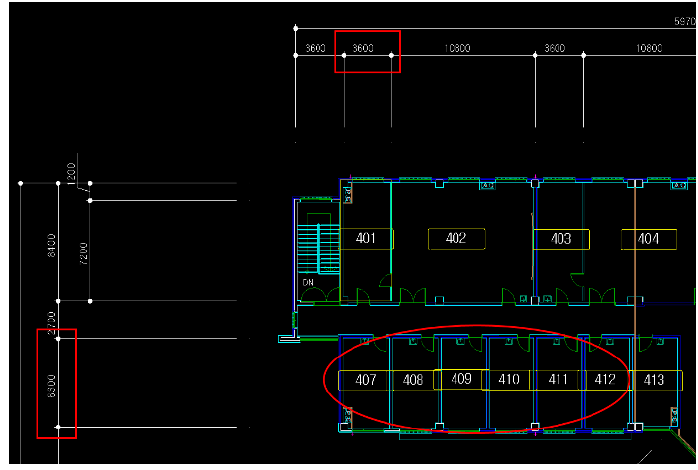
Figure 2. Floor plan of the study site.